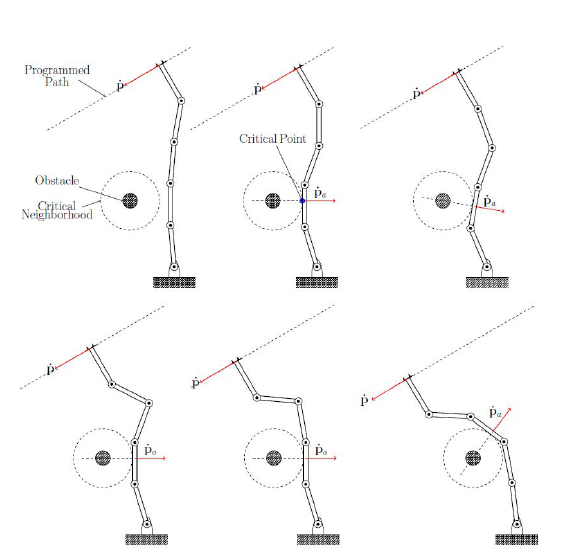
Figure 3: Obstacle avoidance strategy on a 5-axes pla- nar arm.